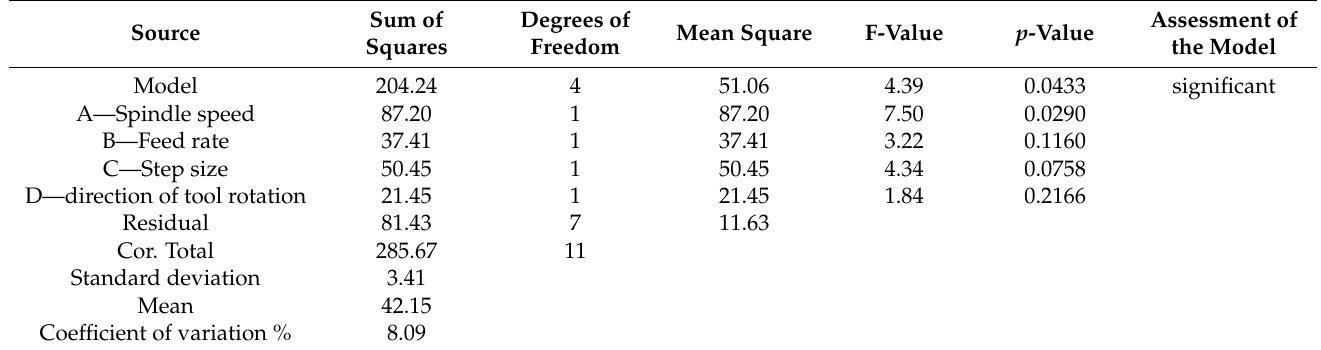
Table A3. ANOVA results of the Sz parameter measured on the inner side of the drawpiece.